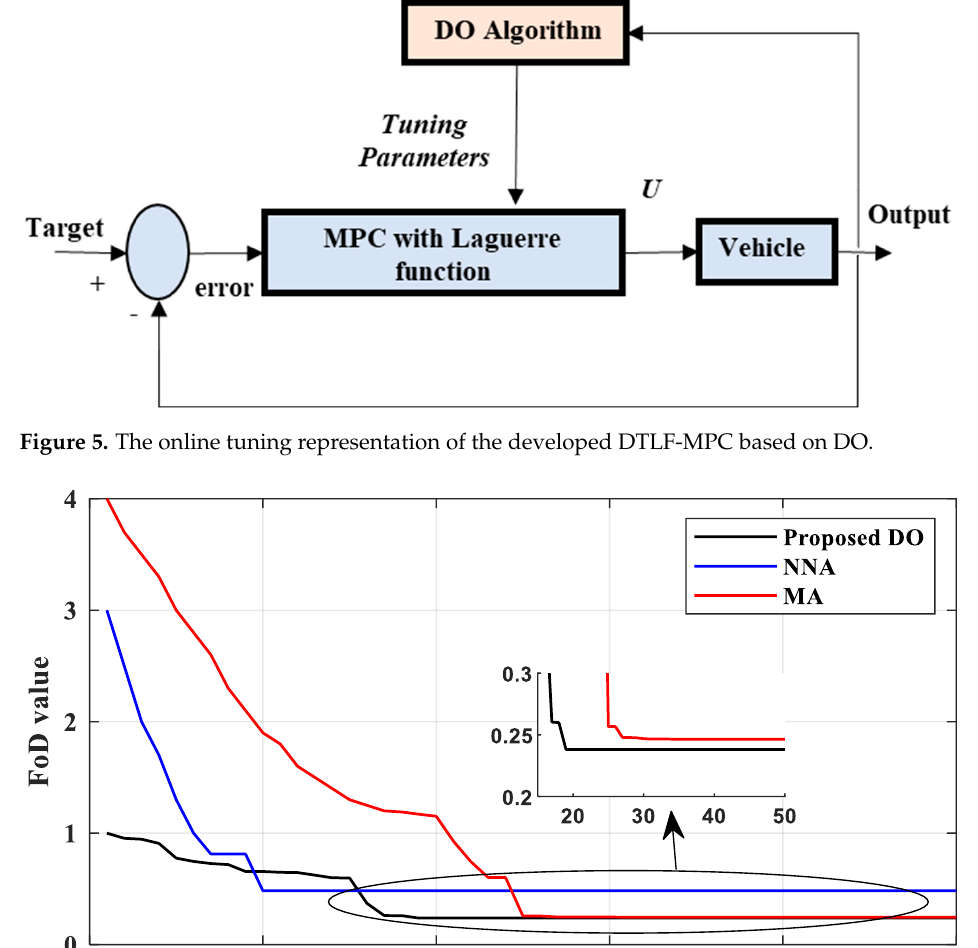
the DO are compared with NNA [39] and MA [40] to evaluate the system performance. Figure 6 clarifies the optimization efforts of the utilized DO versus the NNA and MA for the factors tuning the developed DTLF-MPC. In Figure 7, the values of the cost function for all algorithms are described in the chart shapes for a clearer comparison between them. Table 1 includes the developed DTLF-MPC gains, and the cost function value depends on the utilized DO, NNA, and MA. Figures 6 and 7 and Table 1 clarify that the proposed DO can achieve the minimum value for the cost function with a fast convergence rate compared to NNA [39] and MA [40].